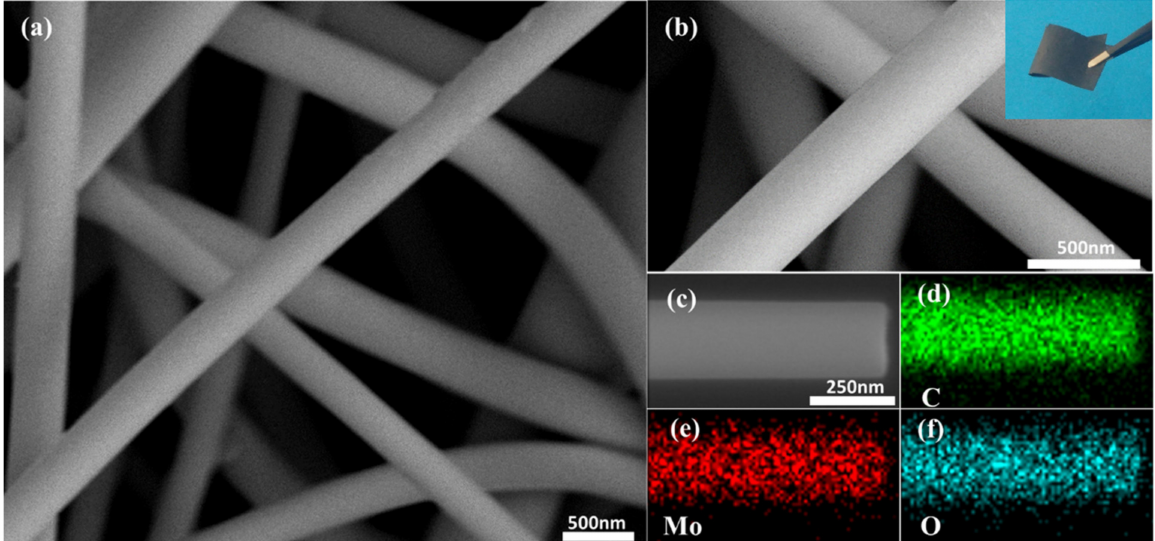
Figure 2. ( a , b ) Field-emission scanning electron (FESEM) images and optical picture of the MoO 2 /C nanofiber membrane; ( c ) the corresponding EDS mapping images of ( d ) C, ( e ) Mo and ( f ) O elements.